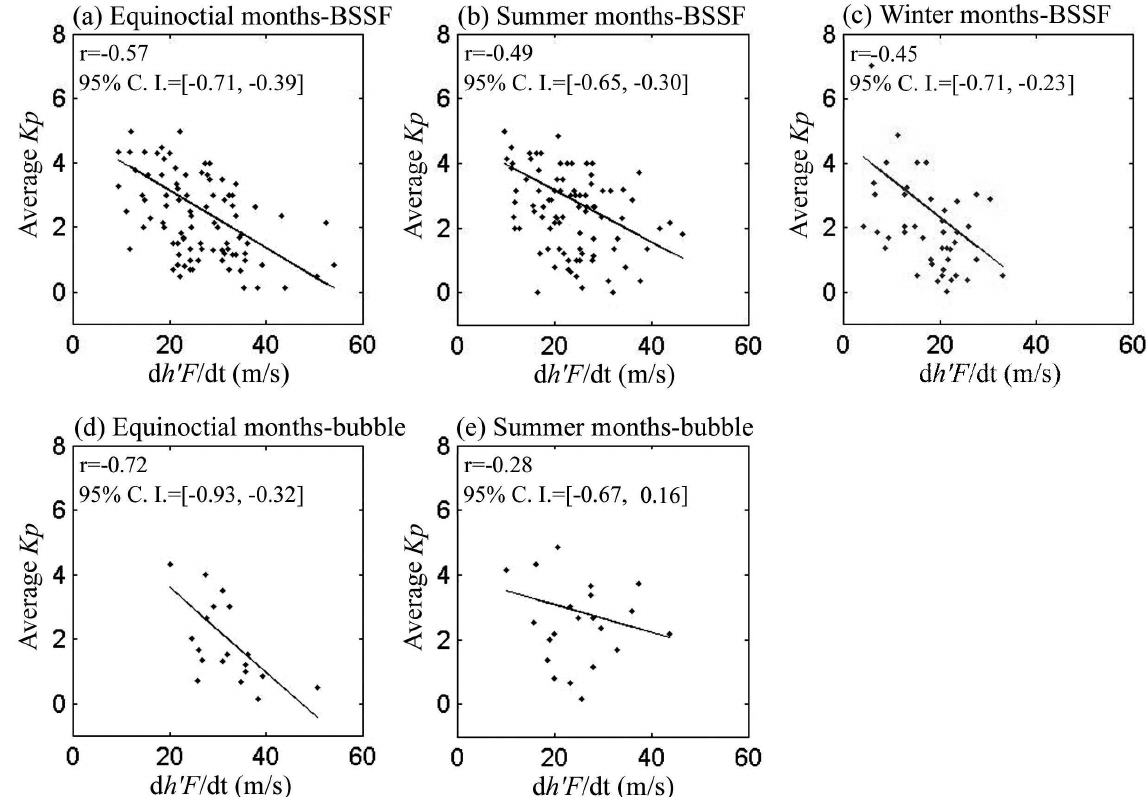
Fig. 7. Scatter plots of K p and d h 0 F /dt for the BSSF and bubble events in the equinoctial (a, d) , summer (b, e) , winter (c) months. The correlation coefficient and 95% corresponding confidence interval (C. I.) are displayed in the upper-left corner. The solid line is the least-squares straight line fitting to the